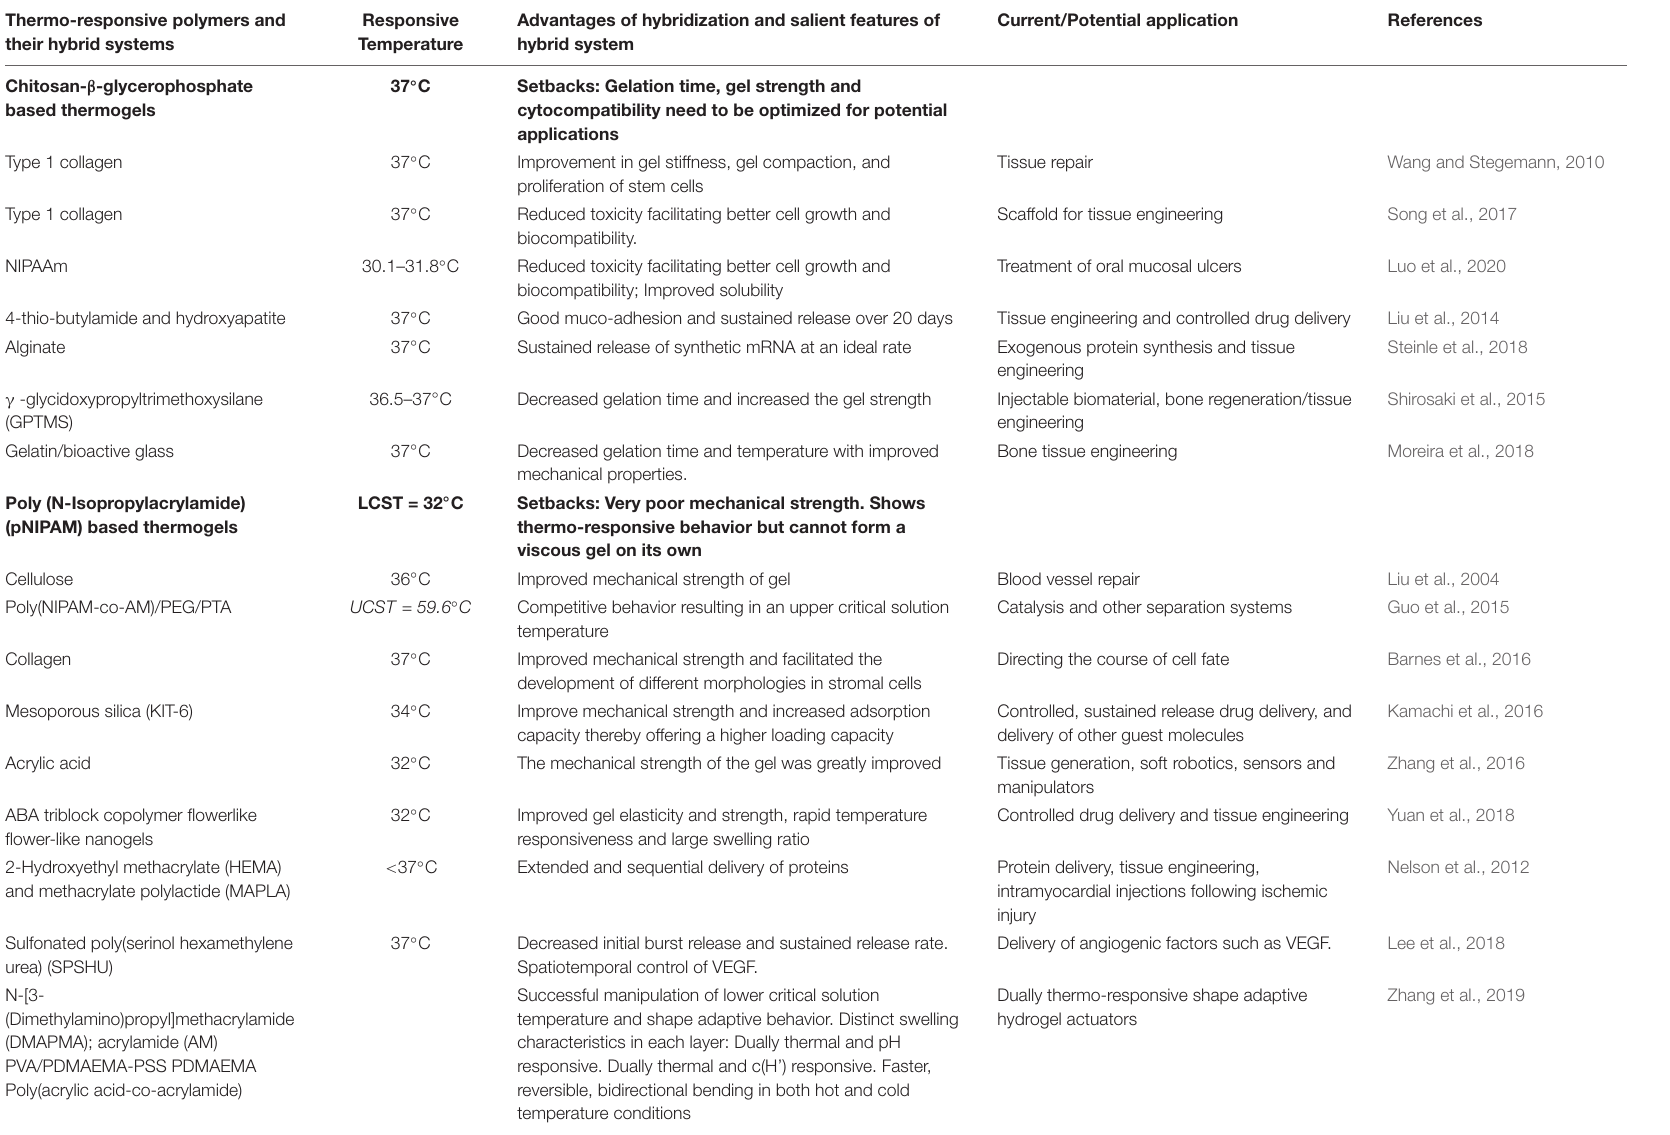
TABLE 1 | Summary of hybrid thermo-gelling